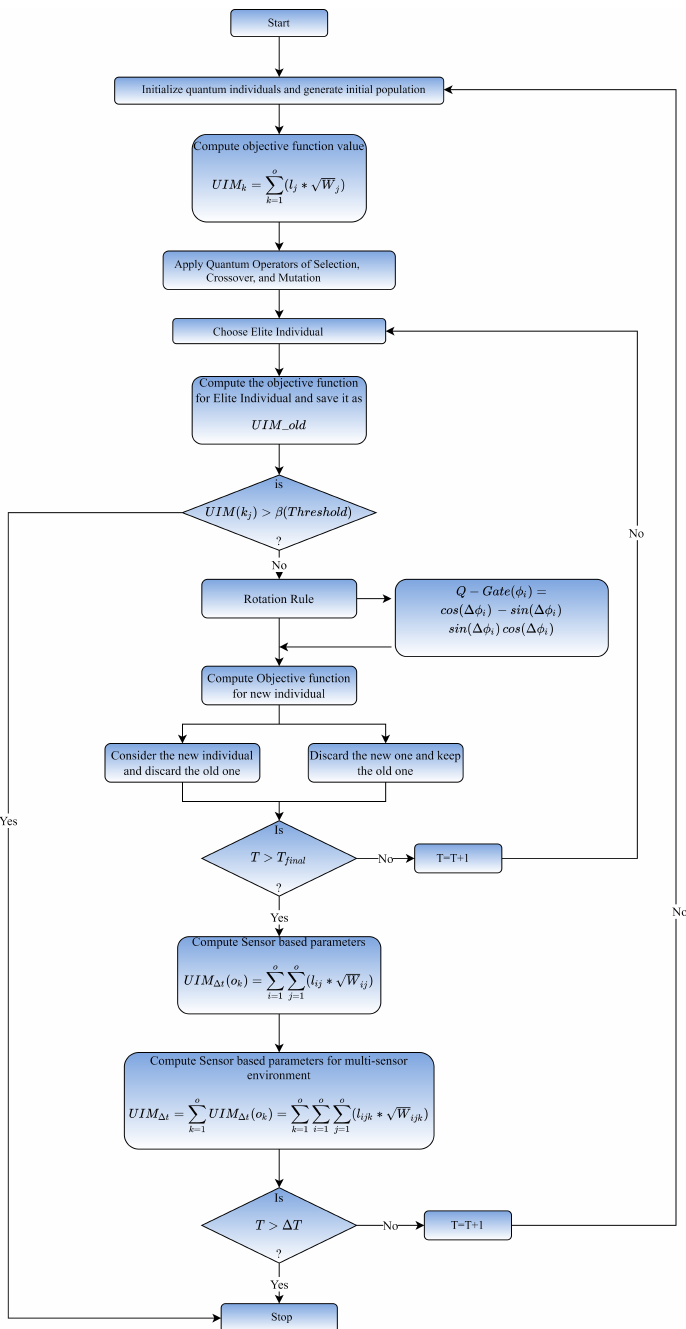
Figure 4. Local Search